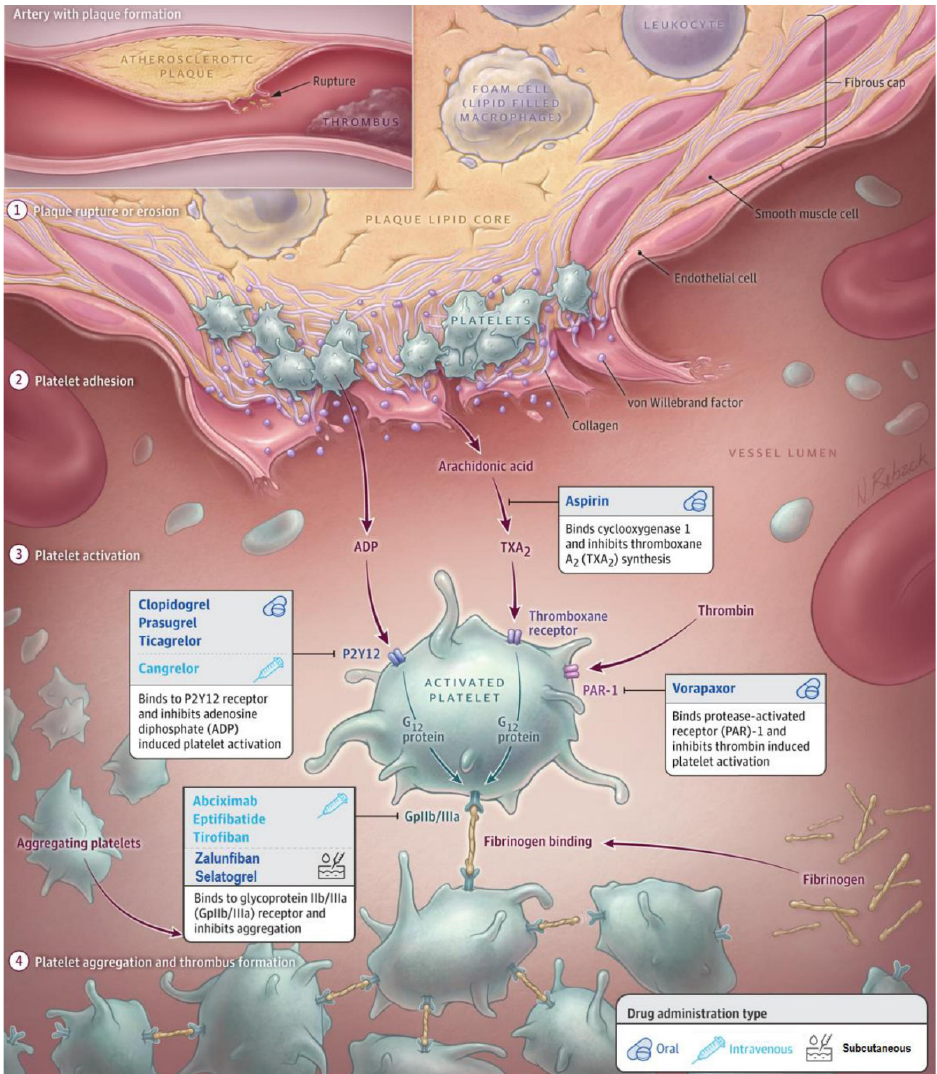
Figure 1. An overview of established and newer antithrombotic agents with different administration types in the context of acute coronary syndrome.